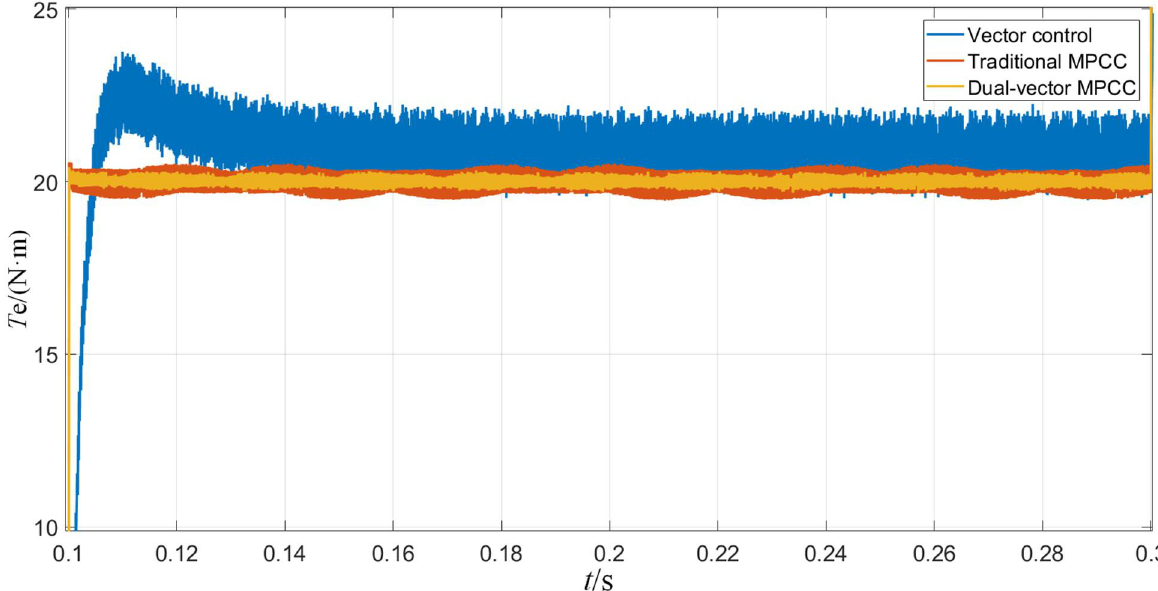
Fig 11. Torque waveform when the motor is loaded with